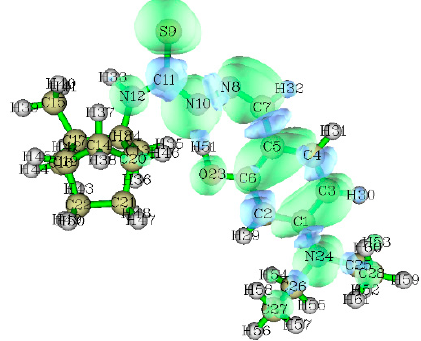
Figure 7. The Spin density distribution of TSC-2 radical.